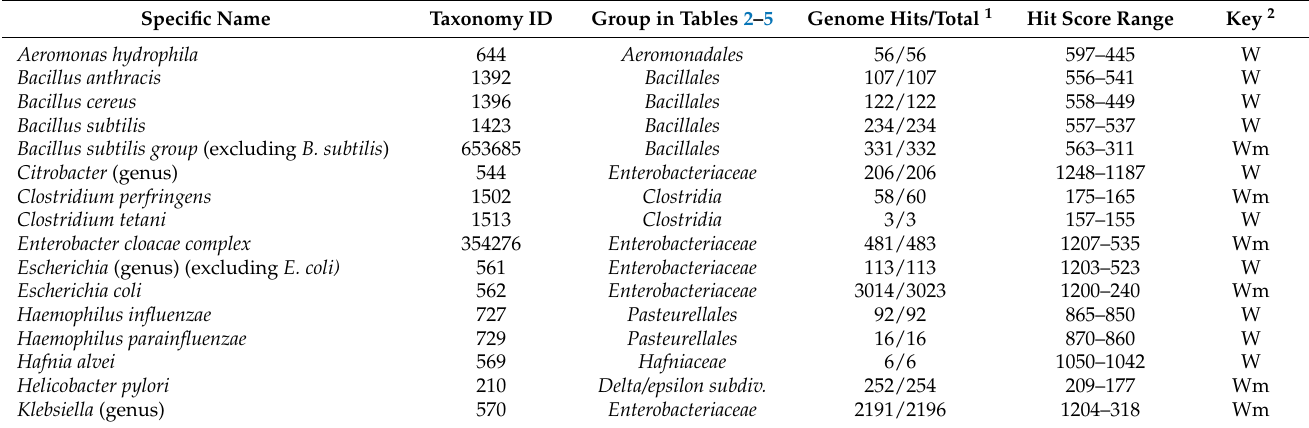
Table 6. Selected pathogens that contain or do not contain cpdB -like genes, as obtained by TblastN analysis using S. enterica CpdB as the query without limiting to “sequences from type